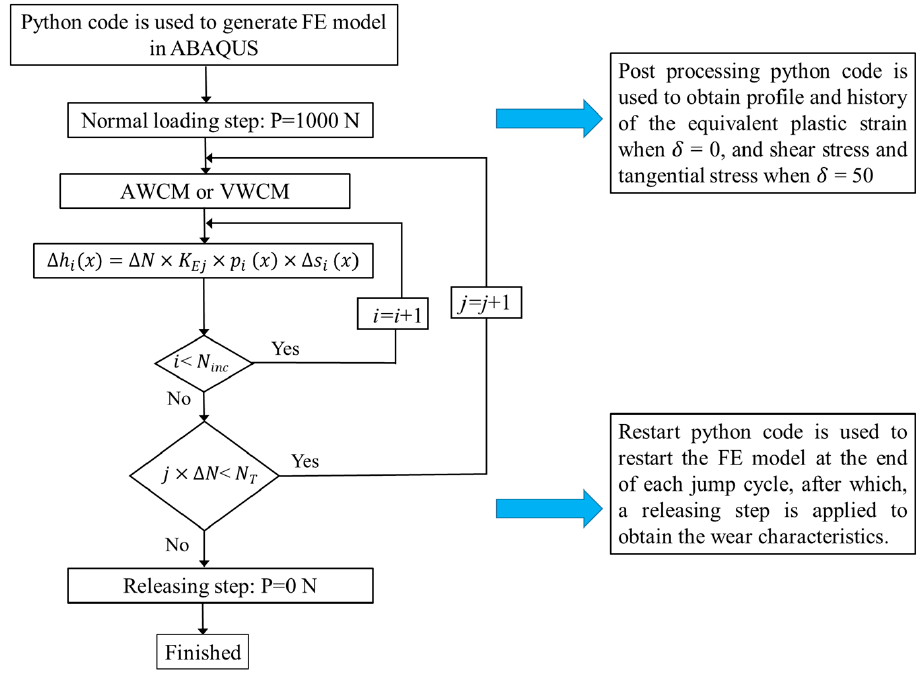
Figure 15. Flowchart of numerical implementation for cylindrical pad and flat specimen.